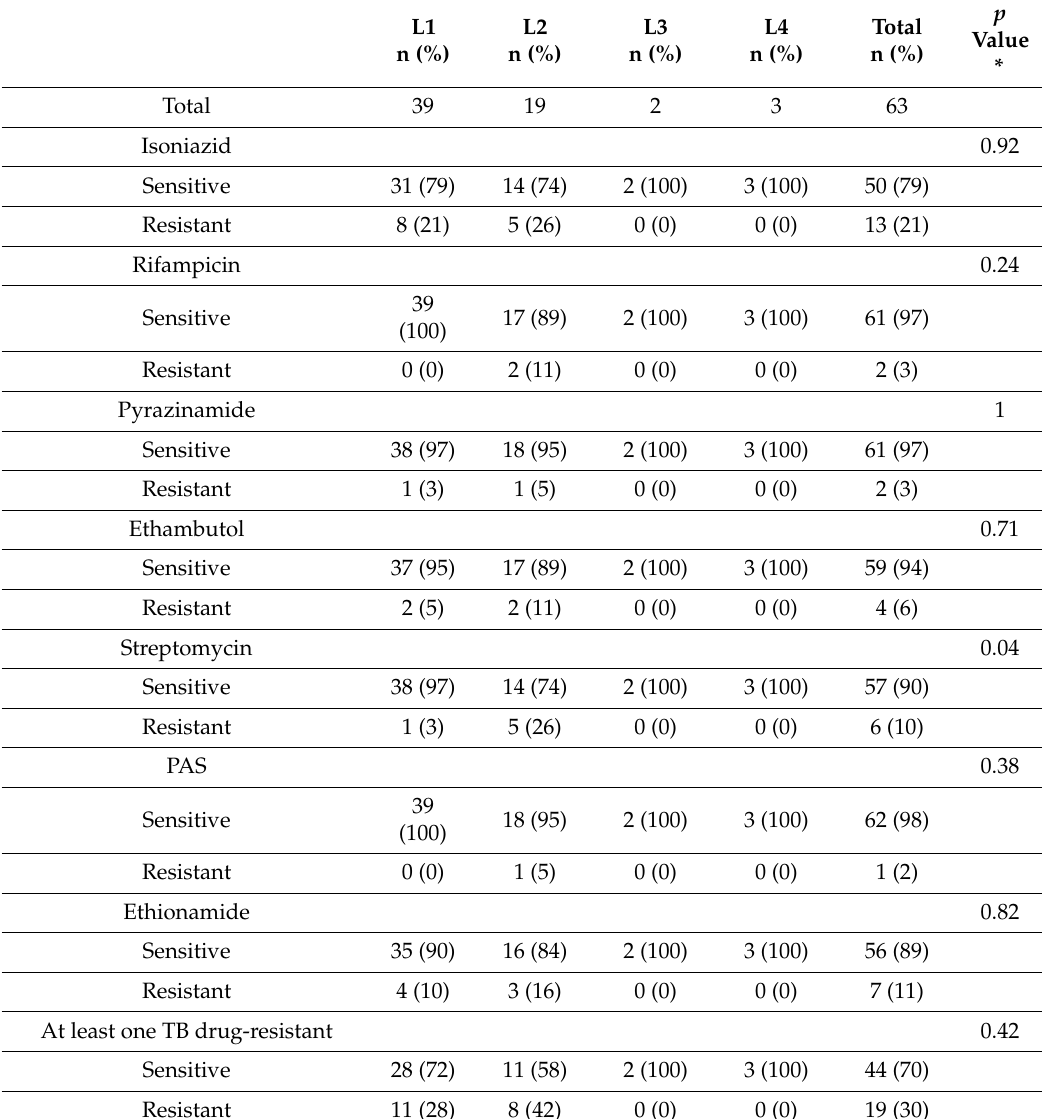
Table 5. The number (%) of MTB Isolates with Di ff erent Drug Susceptibility Profile Belonging Various Major